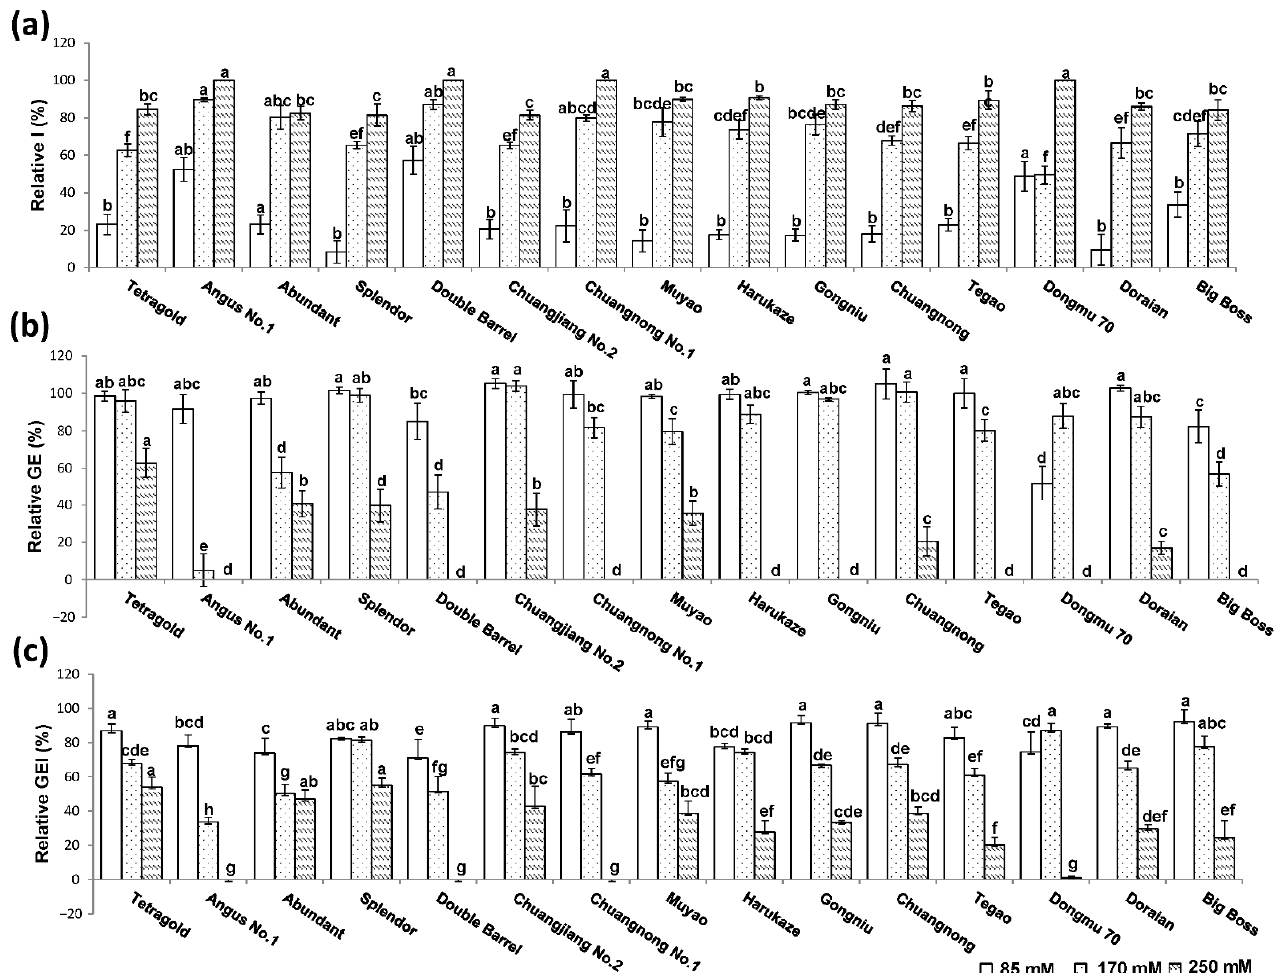
Figure 2. The relative inhibition rate of shoot elongation (I), germination energy (GE), and germination index (GEI) for each cultivar under different NaCl treatment; ( a ) relative inhibition rate of shoot elongation response to different NaCl concentrations in 15 Italian ryegrass cultivars; ( b ) relative germination energy response to different NaCl concentrations in 15 Italian ryegrass cultivars; ( c ) relative germination index response to different NaCl concentrations in 15 Italian ryegrass cultivars. For a single trait, relative value was the ratio of observed value in treatment relative to the control. Error bars are ± standard deviation. Columns marked by the same lower-case letters for a given NaCl concentration are not significant at p < 0.05 (Tukey’s test) for the comparison of different cultivars.